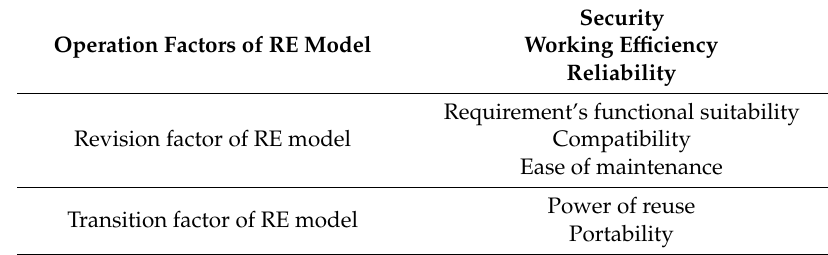
Table 1. Classification factors of RE